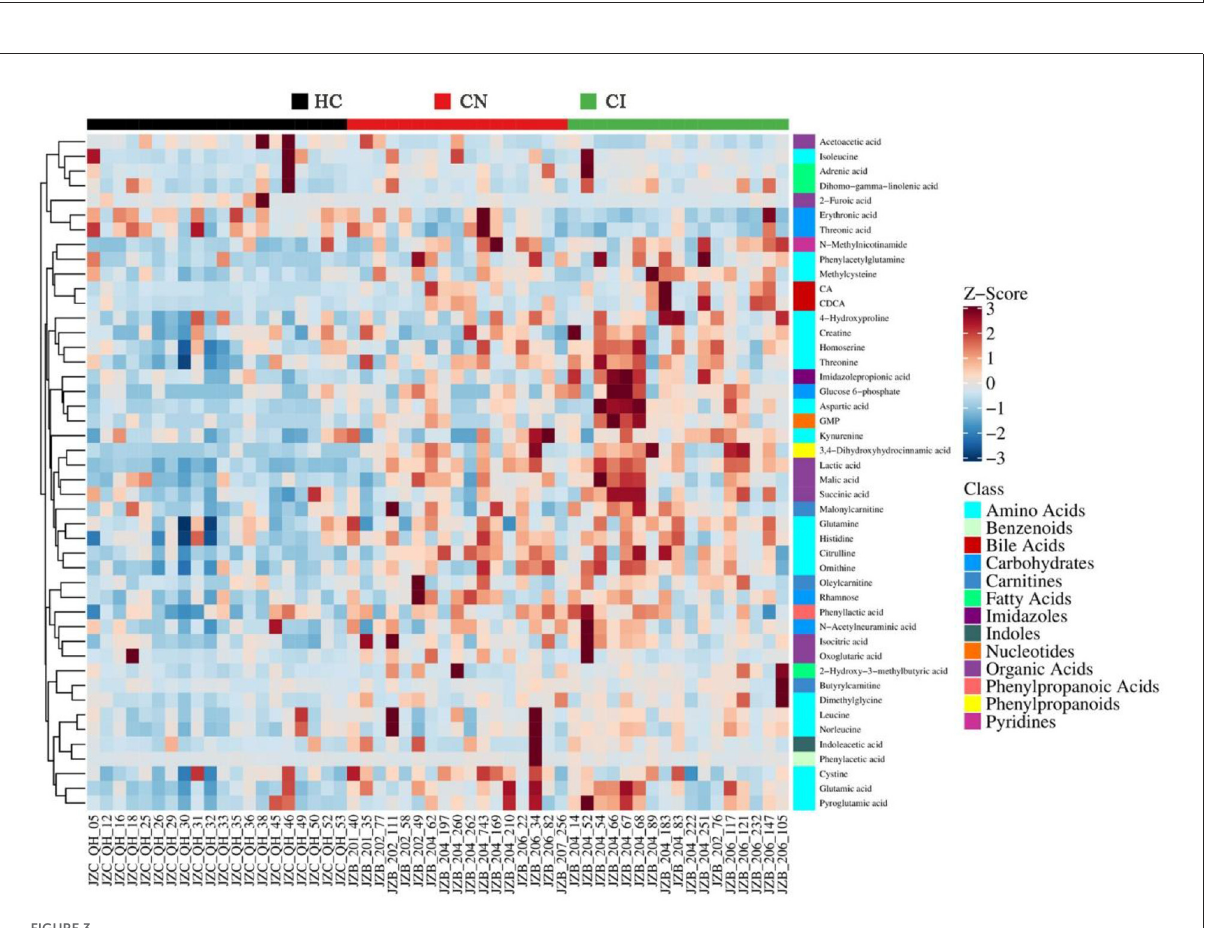
FIGURE3 Heat map of the 46 differentially expressed metabolites between HC, CN and CI groups. The blue band indicates a decreased level of metabolite, and the red band indicates an increased level of metabolite.